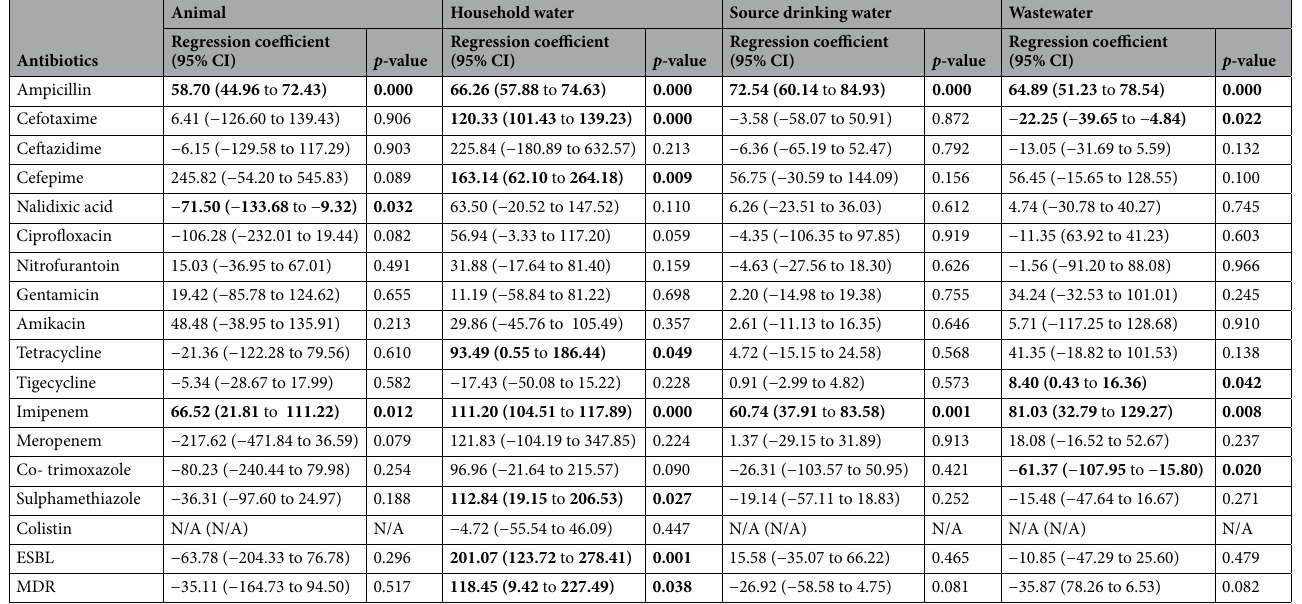
Table 1. Temporal associations between the proportion of resistance to antibiotics in children aged 1–3 years old and that of animals, household water, source drinking water and wastewater within the same